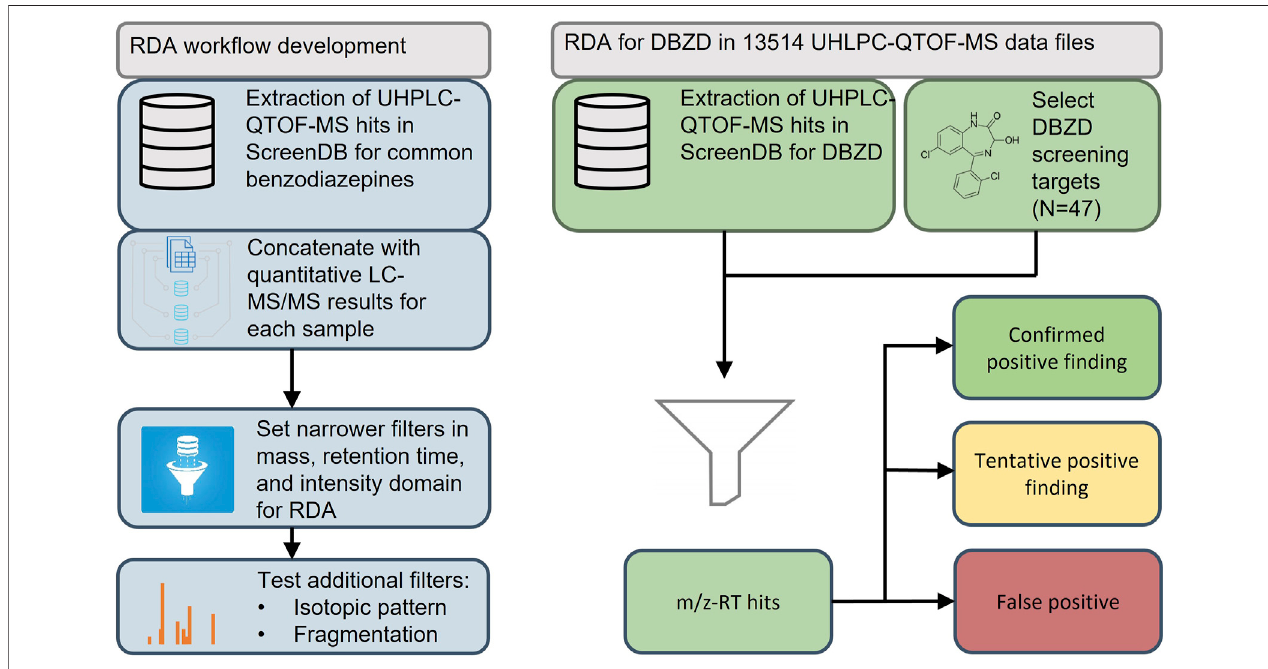
FIGURE 1 | Work fl ow for the development and application of a retrospective data analysis for designer benzodiazepines (DBZDs) in whole blood. QTOF-MS, quadrupole time of fl ight – mass spectrometry; LC-MS/MS, liquid chromatography – tandem mass spectrometry; RDA, retrospective data analysis; RT, retention time.